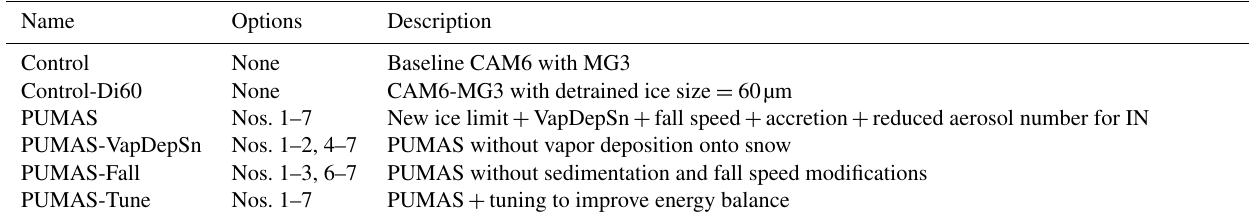
Table 1. Description of the simulations. Numbers in the options column correspond to the changes listed in Sect.